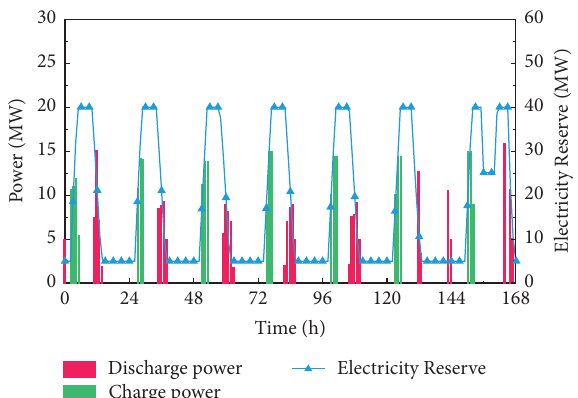
Figure 11: Optimal scheduling situation of electric vehicles.